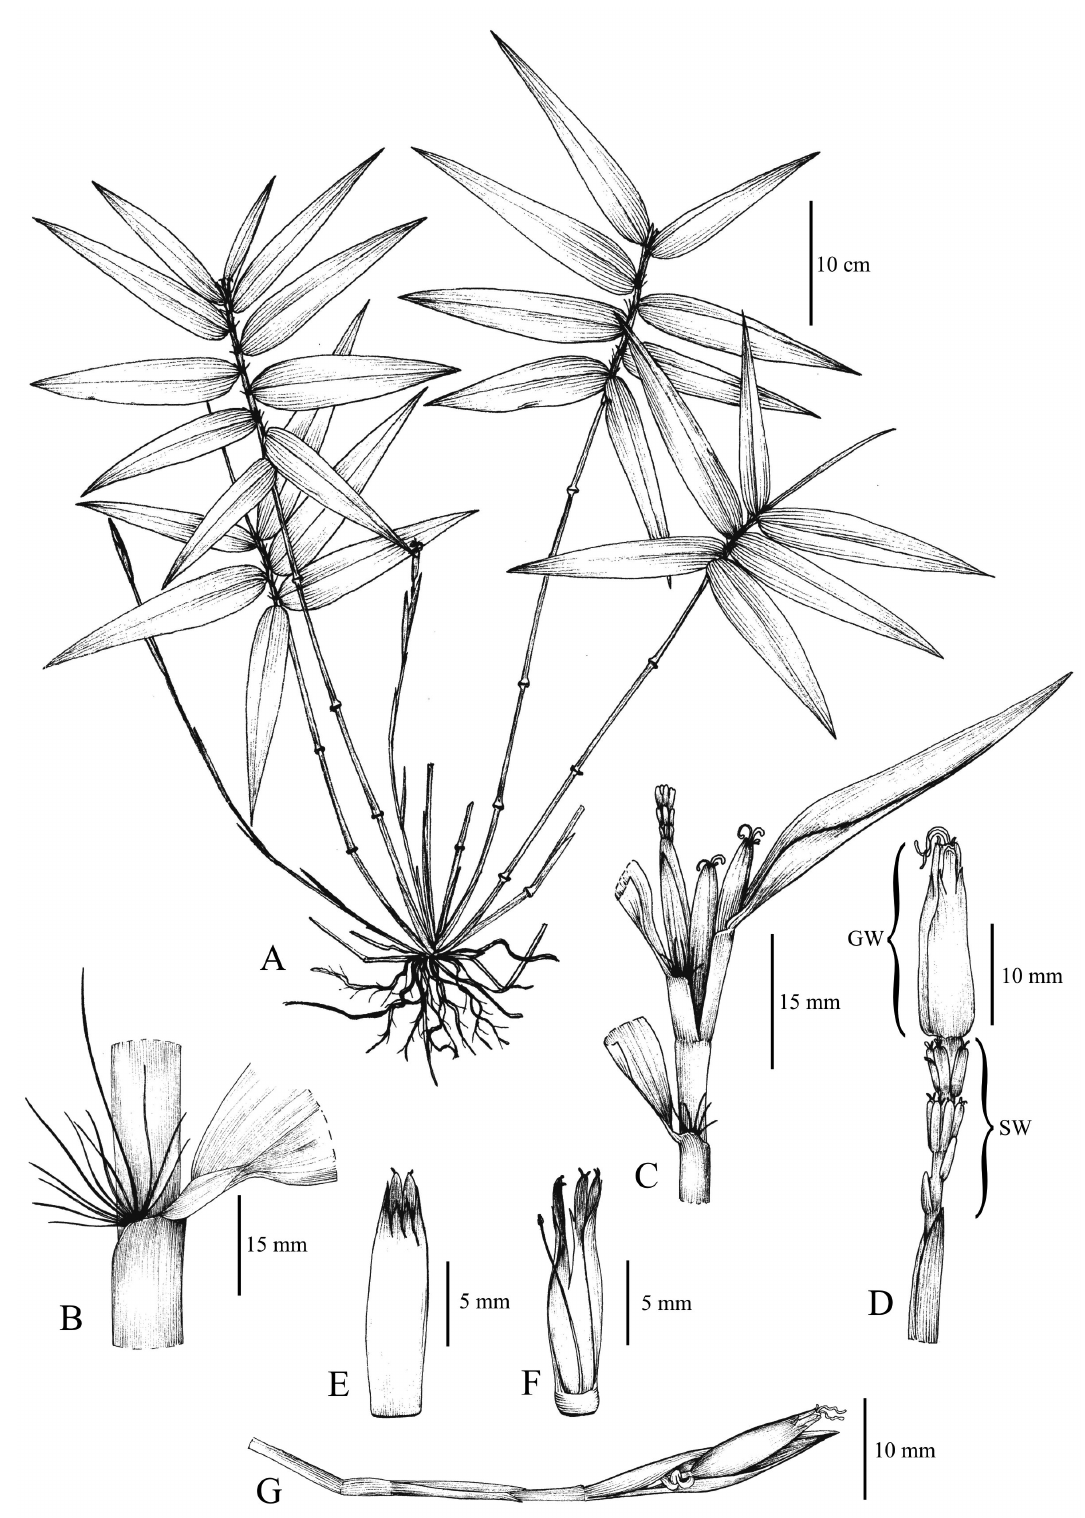
Figure 4 – Eremitis vinacea . A . Habit. B . Detail of the leafy culm showing the fimbriae at the apex of the leaf sheaths. C . Leafy culm inflorescences enclosed by spathaceous bracts. D . Decumbent culm inflorescence with spathaceous bracts removed, showing a gynecandrous whorl (GW) above and three staminate whorls (SW) below. E – F . Gynecandrous whorl. E . Abaxial view of the staminate spikelets. F . Adaxial view of the staminate spikelets showing the rachis prolongation. G . Subterranean culm with inflorescence enclosed by spathaceous bracts. From Ferreira & Carvalho 2132 (HUEFS). Illustration by Carla